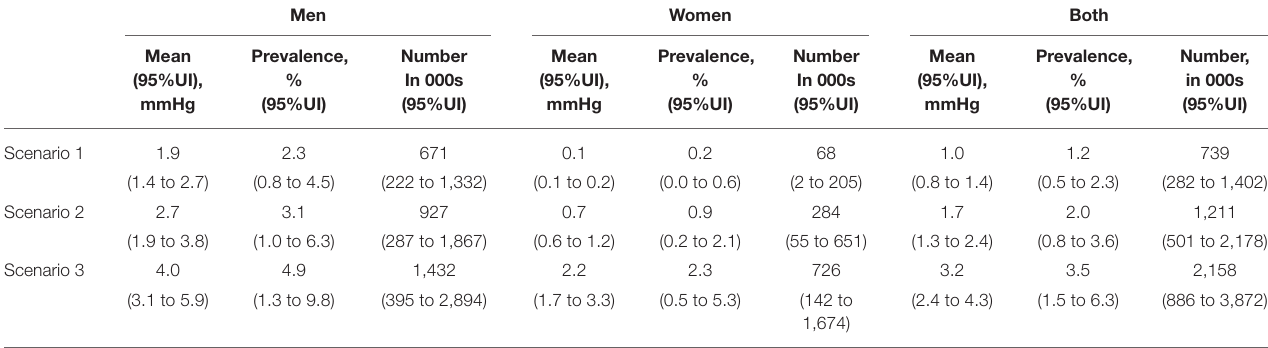
TABLE 1 | Estimated reductions in mean systolic blood pressure, the proportion and number of people with hypertension in